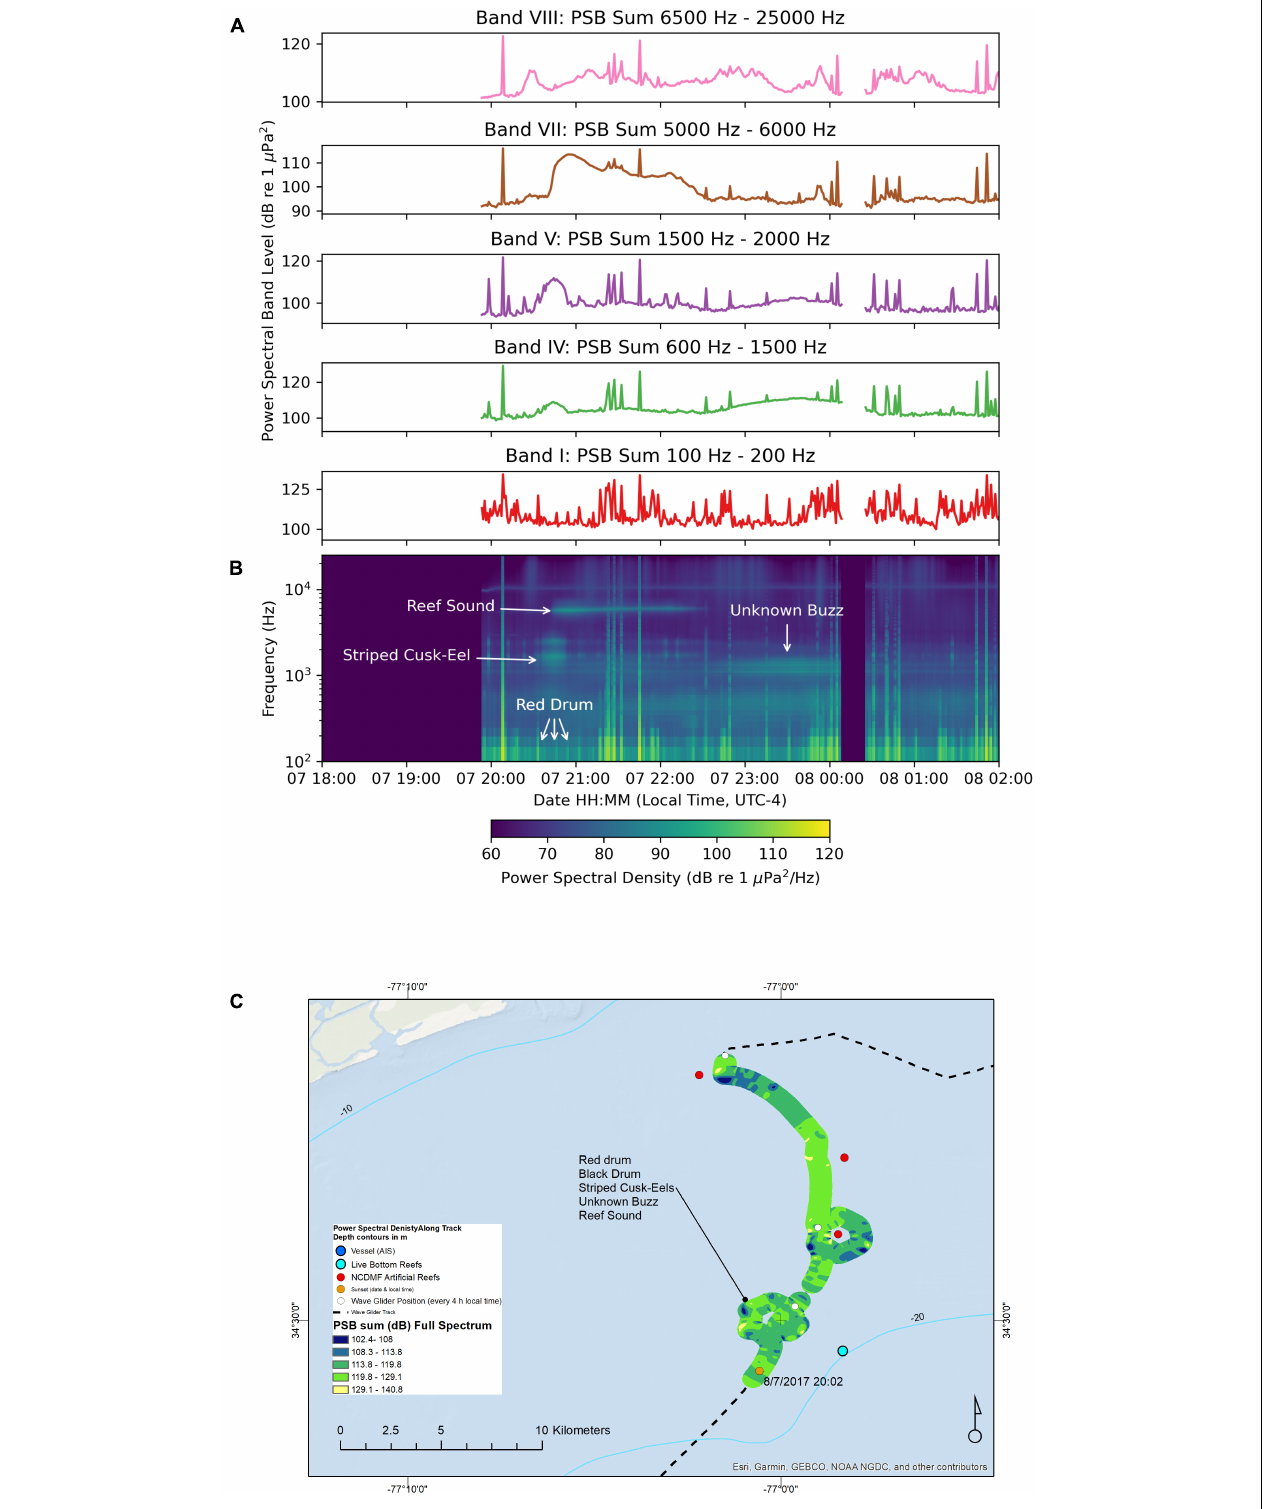
FIGURE 7 | Sound recorded by the wave glider Blackbeard between August-07 18:00 and August-08 02:00. (A) Power spectral band sums for 60 s windows of the recording. (B) Composite spectrogram produced from 60 s average power spectral densities. The gaps in the plots were due to the recording system being rebooted, and thus no data were obtained during this time. (C) Map of the path of the wave glider during the recording. The color of the path indicates the full spectrum PSB sum detected at the location.